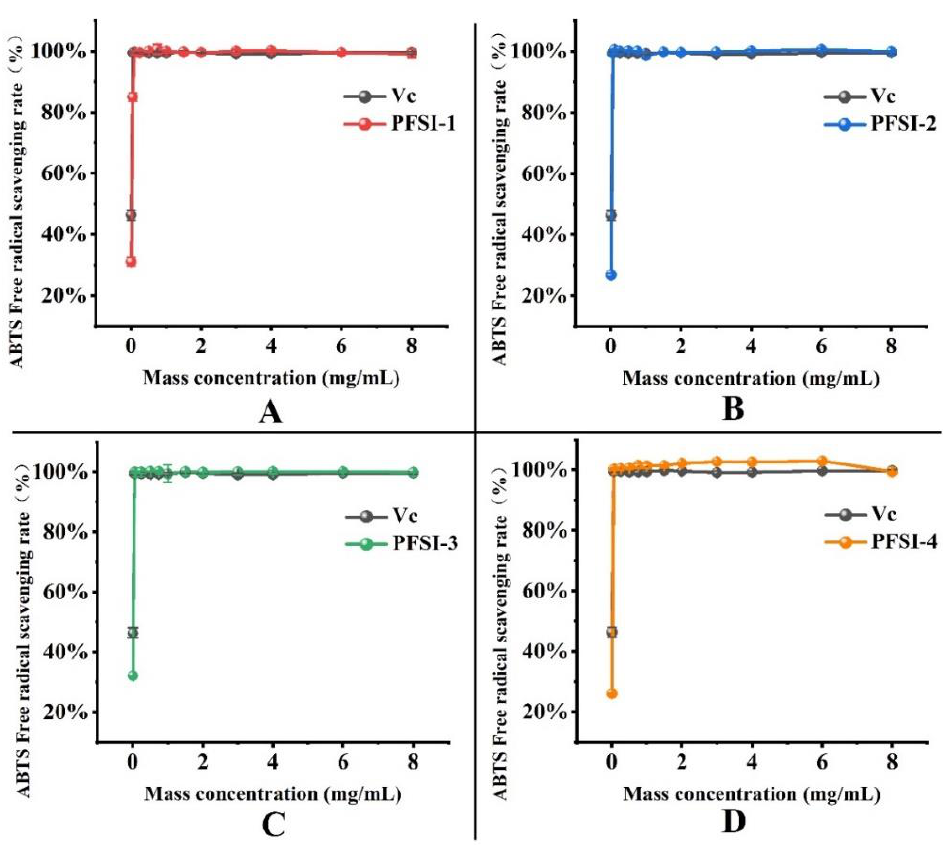
Figure 11. Comparison of the scavenging rate of ABTS · radicals by V C and PFSI. (( A – D ) represent samples of PFSI-1, PFSI-2, PFSI-3 and PFSI-4, respectively).